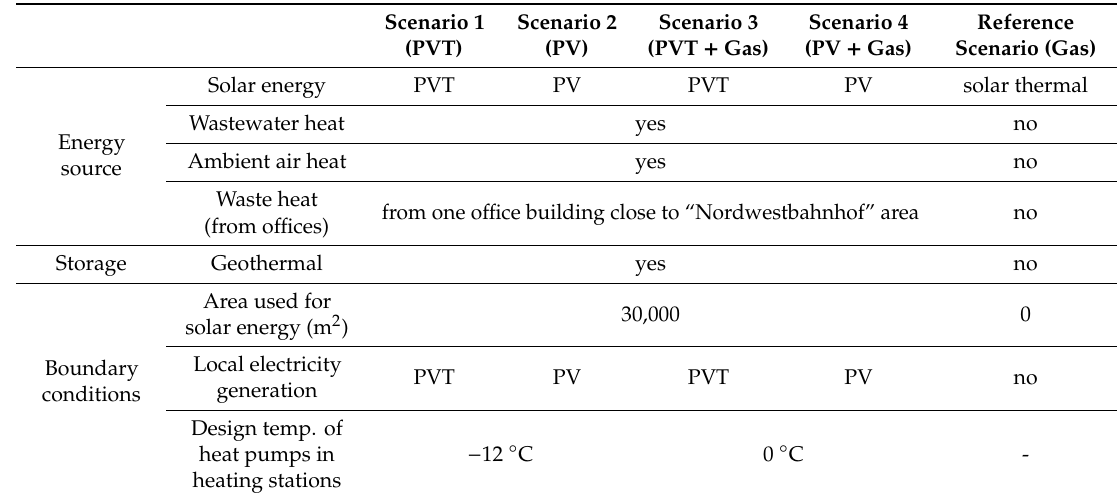
Figure 3. Overview on the intended energy supply system, adapted with permission from [31] OEBB (internal document): Vienna, Austria, 2019. Table 5. Overview of the investigated